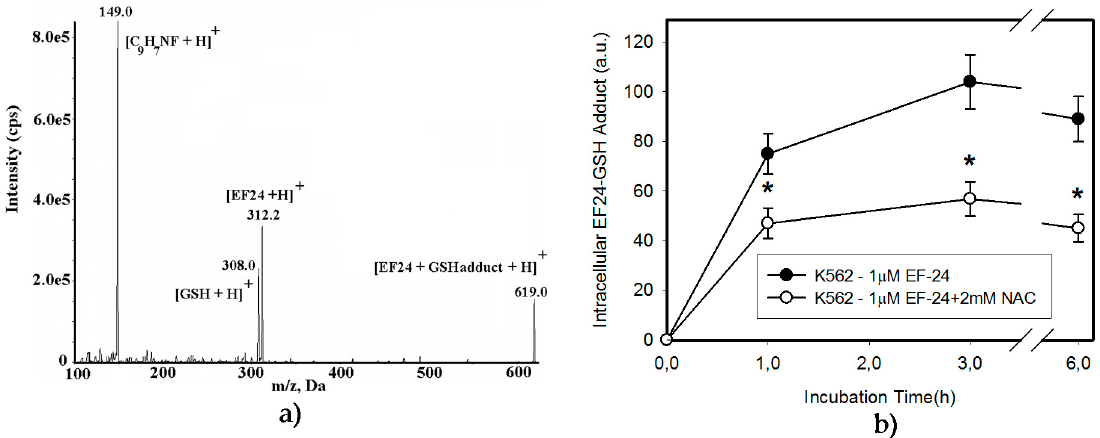
Figure 5. EF-24 forms adduct with GSH. ( a ) MS/MS analysis of the EF-24-GSH adduct: Mass spectrum of the molecular ion of EF-24-GSH adduct (m/z 619.0), result fragment ion [EF-24 + H] + , m/z 312.2, [GSH + H] + , m/z 308.0, and [C9H7NF+H] + , m / z 149.0. ( b ) Effect of NAC on EF-24-GSH adduct formation. Cells were treated with EF-24 or in the combination with 2 mM NAC for given incubation times. The amount of the EF-24-GSH adduct in cells was determined using LC/MS/MS. The experimental points represent mean values from three replicate experiments, with standard deviations; * denotes significant change in EF-24-GSH adduct content between EF-24 and EF-24 + NAC-treated K562 cells.